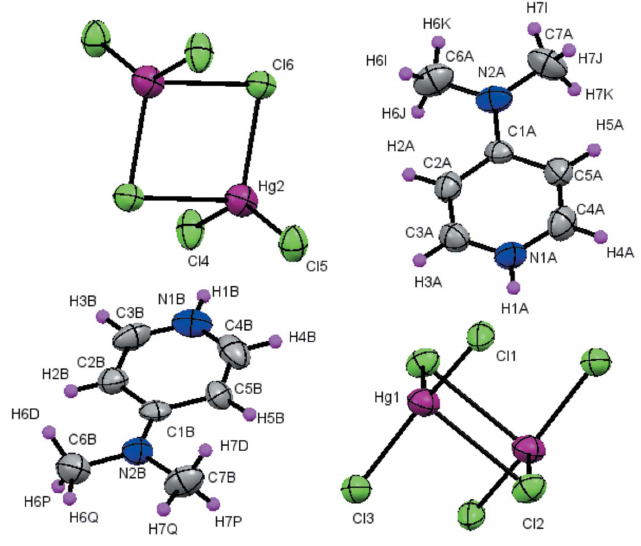
Figure 1 The molecular structure of (I). Atomic displacement parameters for the non-H atoms are drawn at the 50% probability level. Unlabelled atoms are related to labelled ones by the symmetry operation (cid:4) x + 1, (cid:4) y , (cid:4) z +